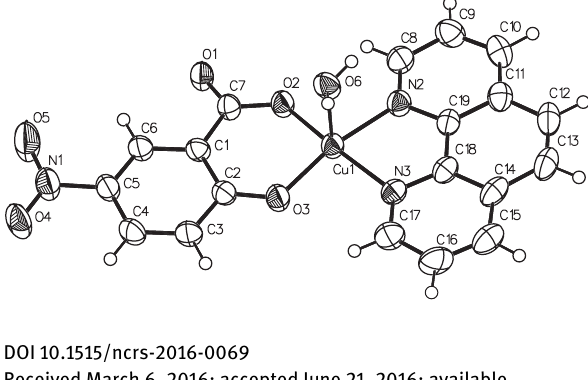
Table 2: Fractional atomic coordinates and isotropic or equivalent isotropic displacement parameters (Å 2